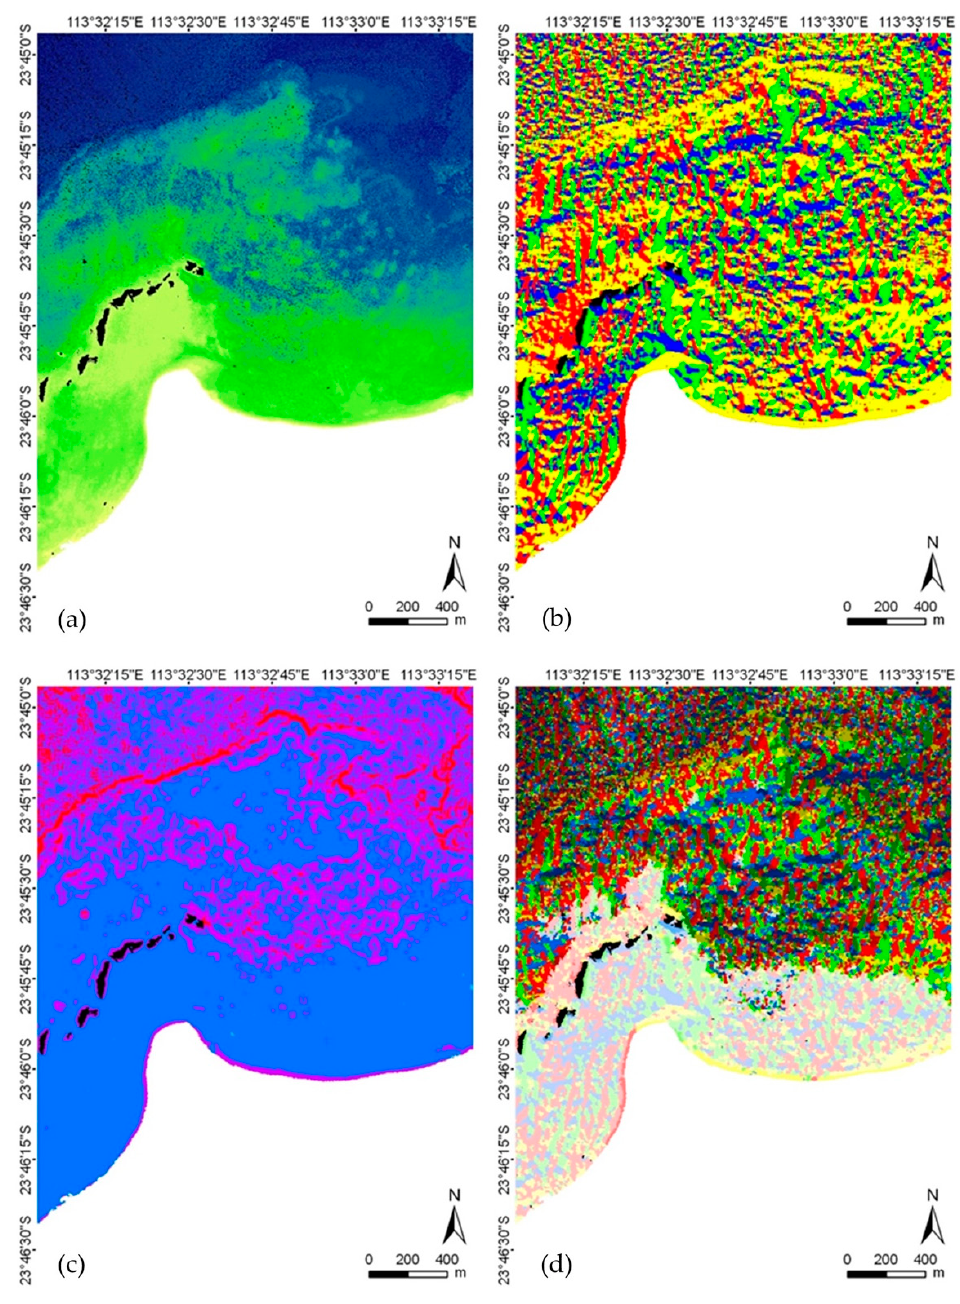
Figure 9. Topographic variables for the focus area at Gnaraloo Bay at the southern end of the Ningaloo Reef. ( a ) depth, ( b ) aspect, ( c ) slope, and ( d ) topographic classification. Legends in Figure 6 ap- ply.